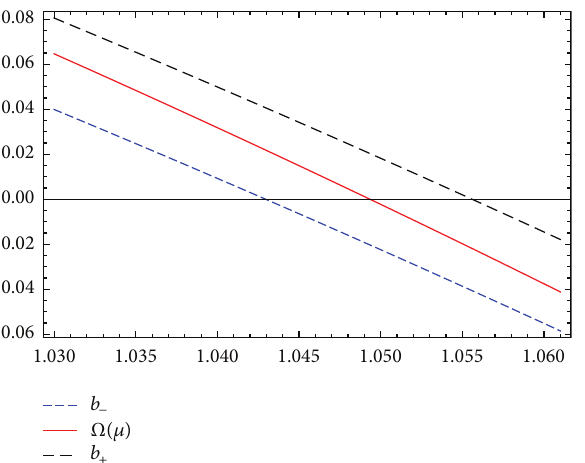
Figure 1: The enclosure interval dominating 𝜇 1 for 𝑚 = 10 , 𝑁 = 15 , 𝜃 = 1/5 , and 𝜀 = 10 −5 .